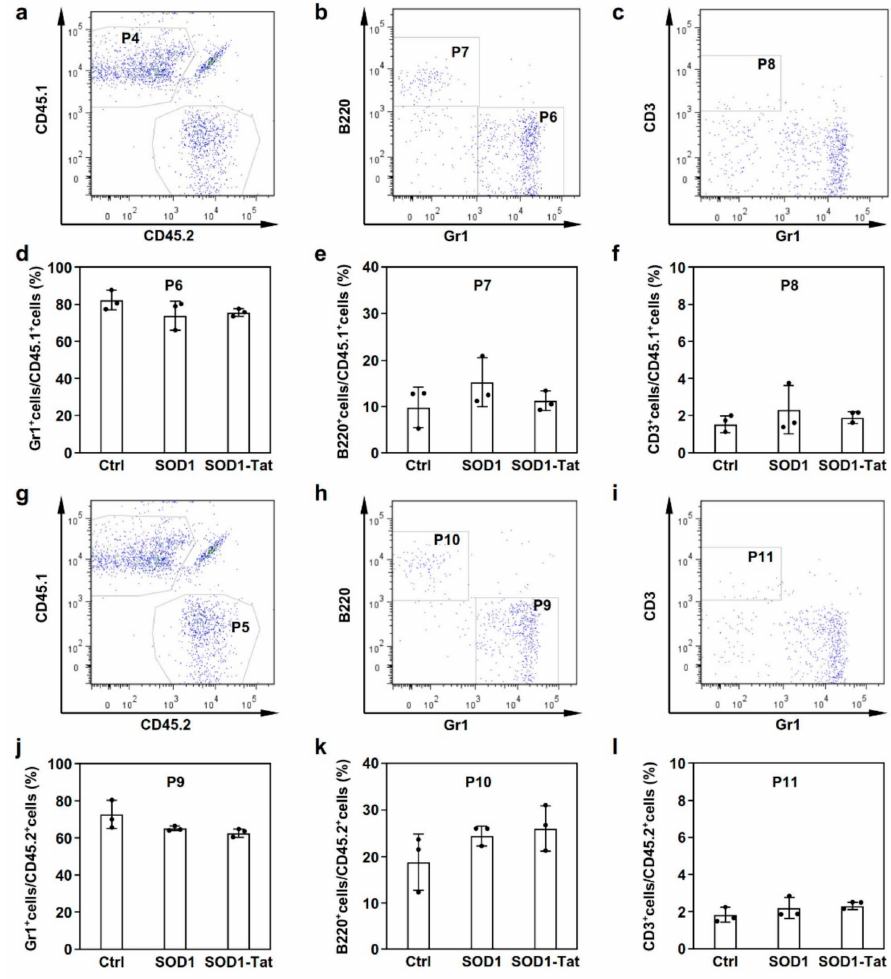
Figure 4. SOD1-Tat had no significant effect on myeloid cell differentiation in the recipient mice two weeks after BMT. ( a ). FACS plots showing chimerism in the indicated blood lineages at two weeks after transplantation. Population 4 (P4) represents CD45.1 + donor-derived WBCs. ( b , c ). Subpopulations of CD45.1 + cells gated for granulocytes (Gr1 + ), B lymphocytes (B220 + ), and T lymphocytes (CD3 + ). CD45.1 + cells (P4) were further divided into three different subpopulations, i.e., populations 6, 7 ( b ), and 8 ( c ), based on gating with cell markers for granulocytes (Gr1 + ), B lymphocytes (B220 + ), and T lymphocytes (CD3 + ). ( d – f ). The percentage ratios of Gr1 + ( d ), B220 + ( e ), or CD3 + ( f ) cells to CD45.1 + cells (P4). ( g ). Population 5 (P5) represents CD45.2 + donor-derived WBCs. ( h , i ). Subpopulations of CD45.2 + cells gated for granulocytes (Gr1 + ), B lymphocytes (B220 + ), and T lymphocytes (CD3 + ). CD45.2 + cells (P5) were further divided into three different subpopulations, i.e., populations 9, 10 ( h ), and 11 ( i ), based on gating with cell markers for granulocytes (Gr1 + ), B lymphocytes (B220 + ), and T lymphocytes (CD3 + ). ( j – l ). The percentage ratios of Gr1 + ( j ), B220 + ( k ), or CD3 + ( l ) cells to CD45.2 + cells